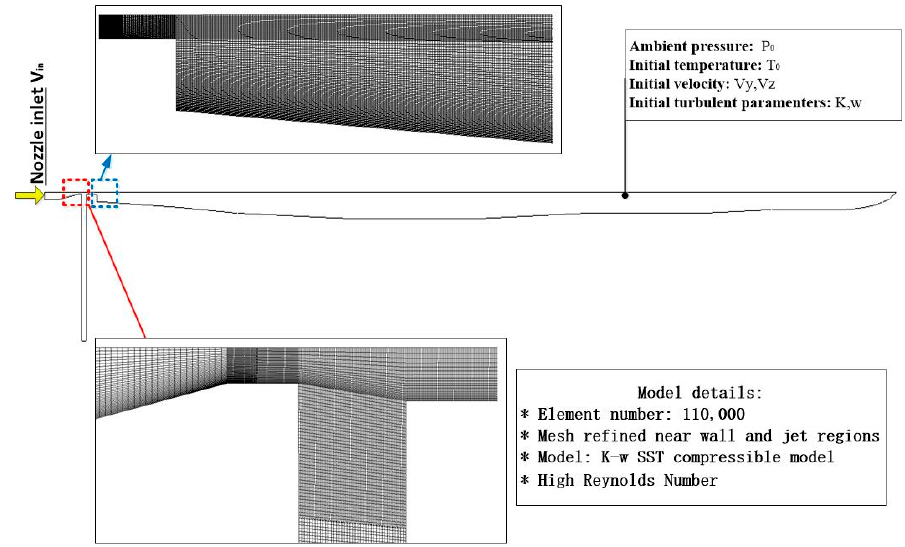
Figure 3. Numerical symmetric model of a SC-CO 2 jet in limited perforation.